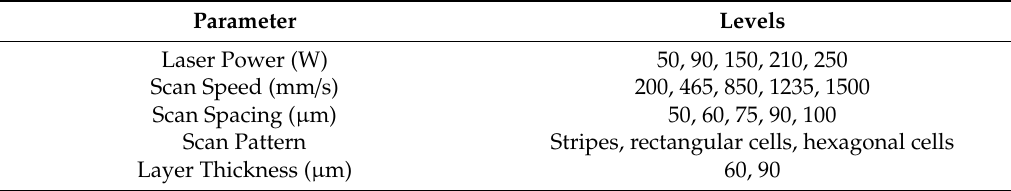
Table 1. Process parameters and